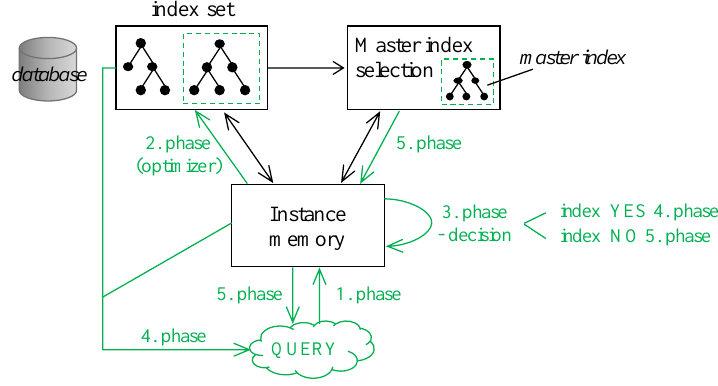
Figure 10. Master indexing.